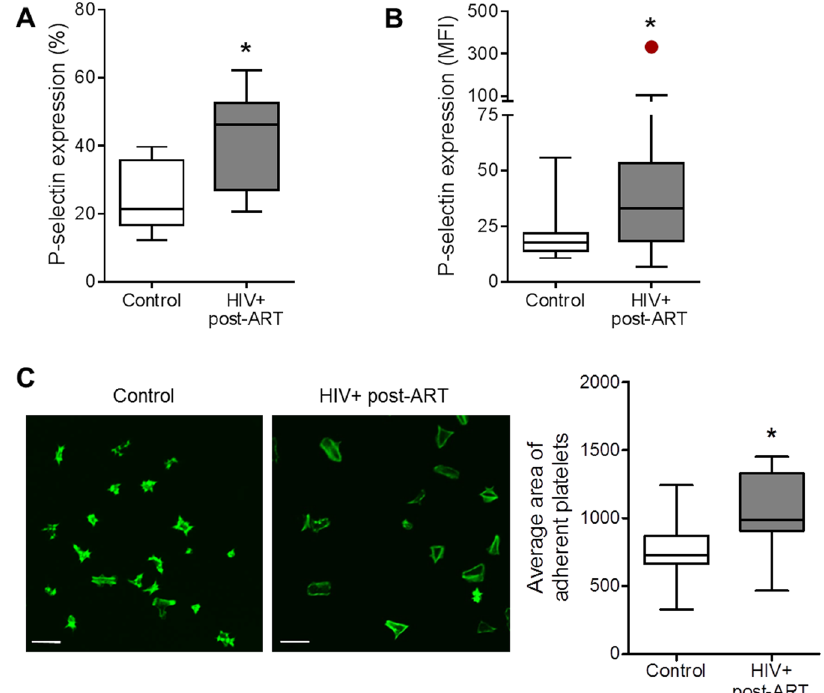
Figure 1. Increased platelet activation in HIV-infected individuals under stable cART. ( A , B ) The percentage of platelets with P-selectin surface expression ( A ) and the mean fluorescence intensity (MFI) for P-selectin labeling on platelets ( B ) were assessed in freshly-isolated platelets from healthy subjects (control) or from HIV-infected individuals under viral control (undetectable HIV-1 viral load in the peripheral blood). ( C ) Average area of spontaneous spreading on fibrinogen-coated surfaces by platelets from control or HIV-1-infected subjects labeled with phalloidin. Images are representative of eight HIV-infected individuals and healthy volunteers analyzed in parallel. Scale bars represent 10 µ m. The horizontal lines on the box plots represent the median, the boxes limits represent the interquartile ranges and the whiskers indicate 5–95 percentile. The dot in panel B represents an outlier (p < 0.05 in Grubbs’ test) that was excluded from statistical analysis. The asterisk ( * ) signifies p < 0.05 compared to healthy